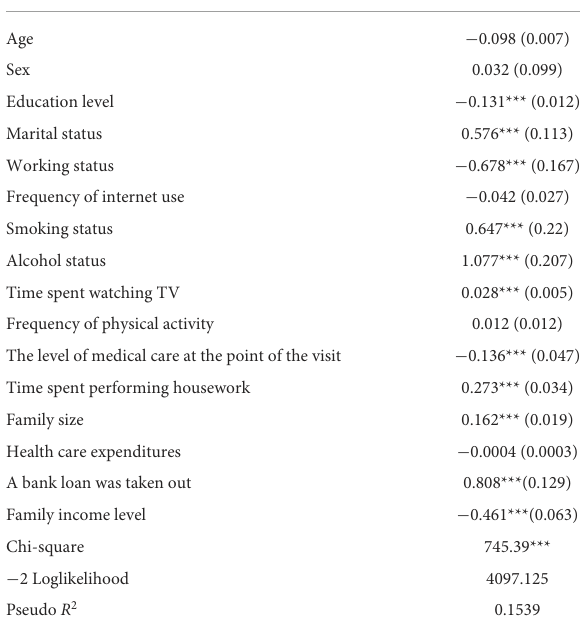
TABLE 4 Binomial logit propensity prediction model for rural relatively poor population to participate in